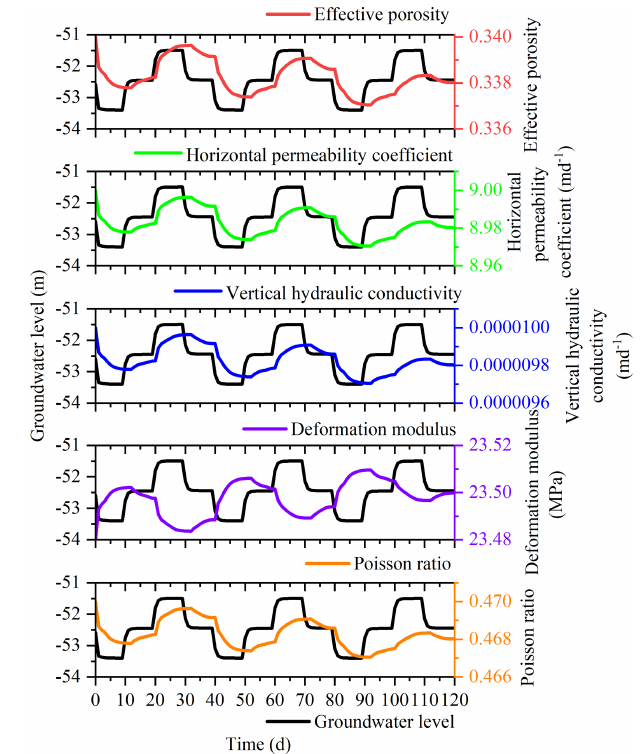
Figure 6. Parameter and water level with stress period in the third confined aquifer group under the first pumping and recharge scheme.